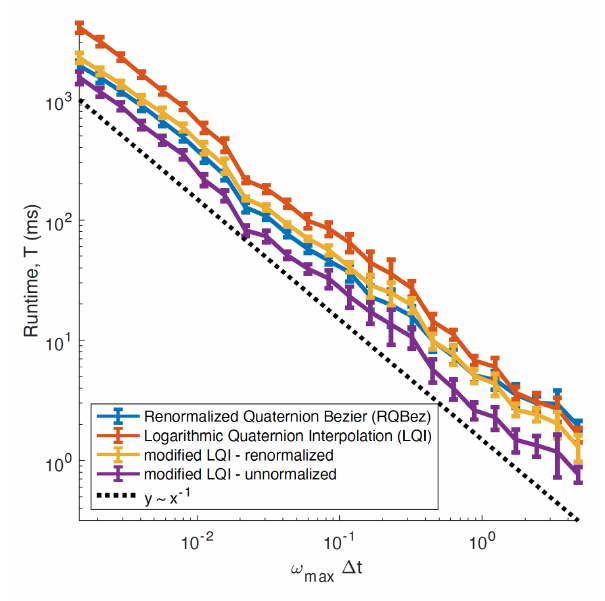
Figure 5. Execution timing in milliseconds for RQBez, LQI, and two forms of mLQI.The line y ∼ x − 1 is provided for visual reference. As can be seen, the unnormalized mLQI performing the fastest out of all methods over widely varying keyframe